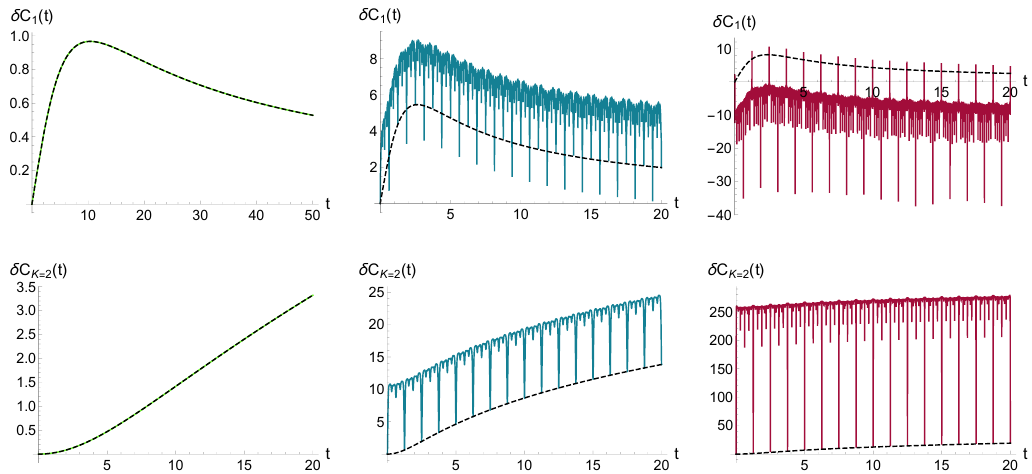
Figure 23 . Evolution of the complexity of the rotating TFD with the initial t = 0 value subtracted, δ C ( t ) ≡ C ( | rTFD(t) i ) − C ( | rTFD(0) i ) for different temperatures. Here L = 1 , N = 1200 , Ω = 0 . 6 and m = 10 − 6 . The temperature is increased from left to right: T = 0 . 1 , 10 , 100 . The dashed black curve in each panel is the zero-mode contribution, which dominates the low-temperature regime.